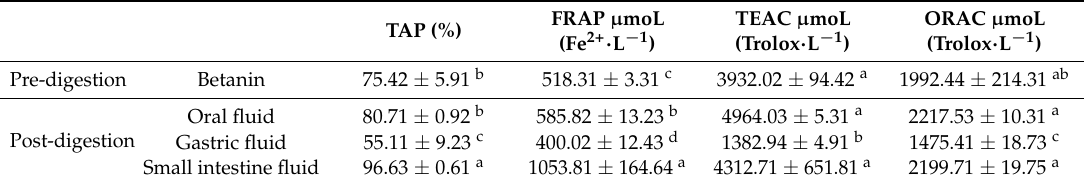
Table 2. Total betanin antioxidant potential and antioxidant activity pre and post in vitro simulated human gastrointestinal